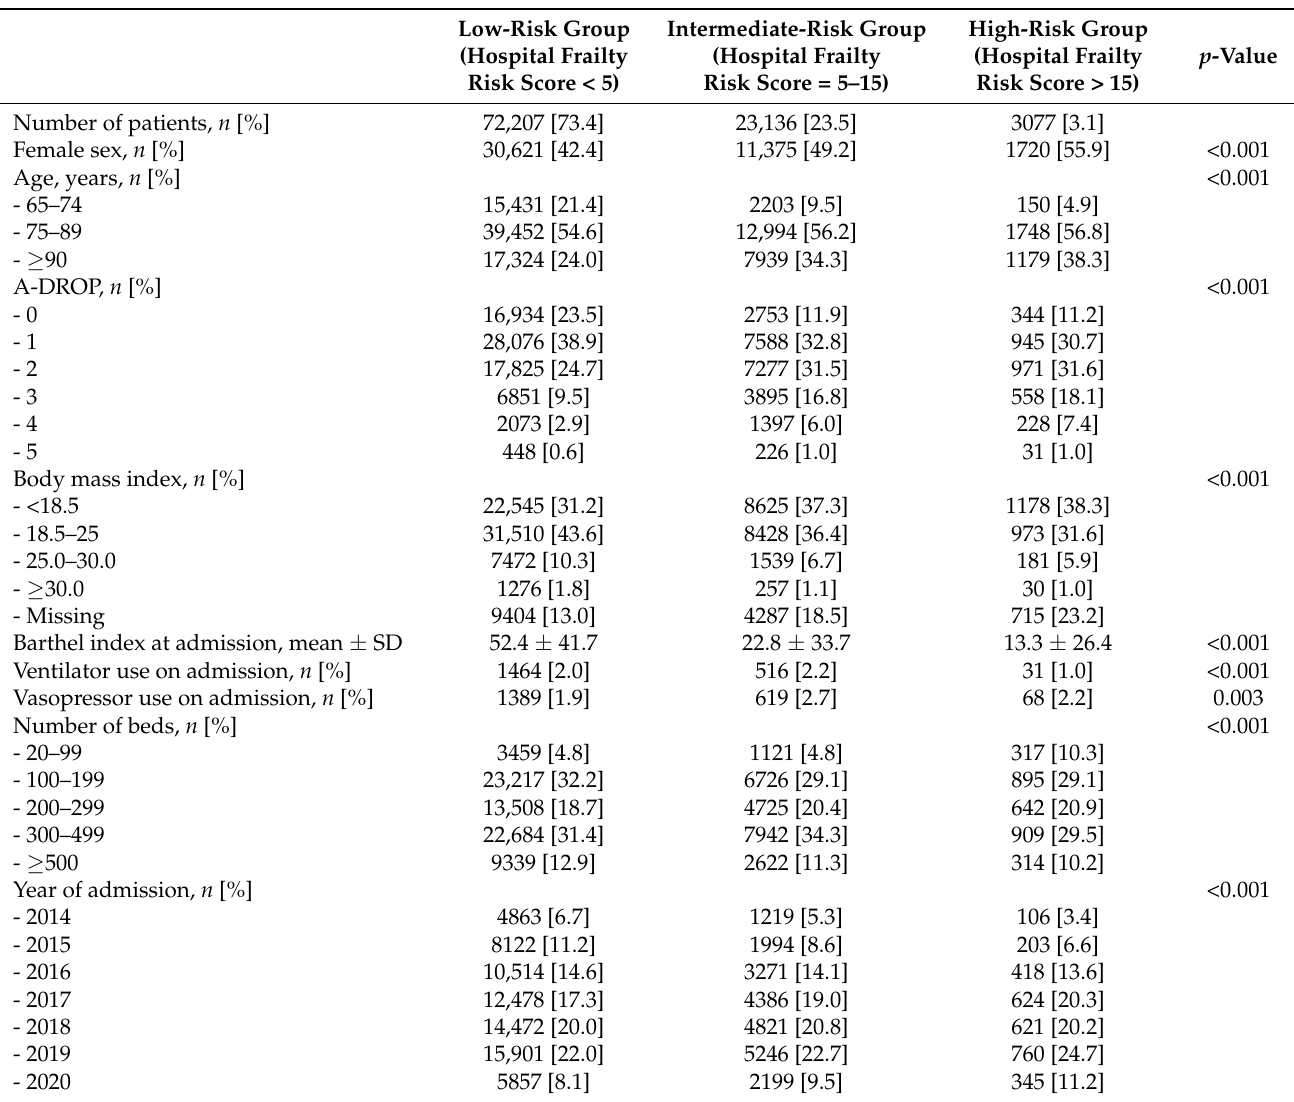
Table 1. Patient